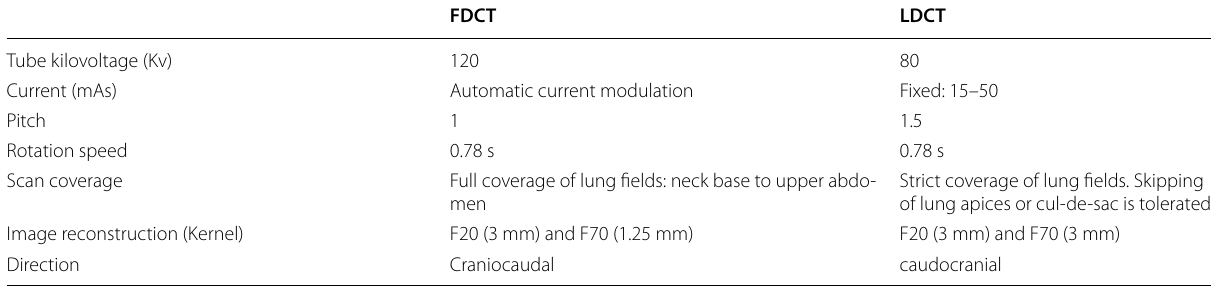
Table 1 Acquisition parameters on 16-row multidetector CT scan (Neuviz-Classic) for the regular full dose protocol (FDCT) and the modified ultra-low dose protocol